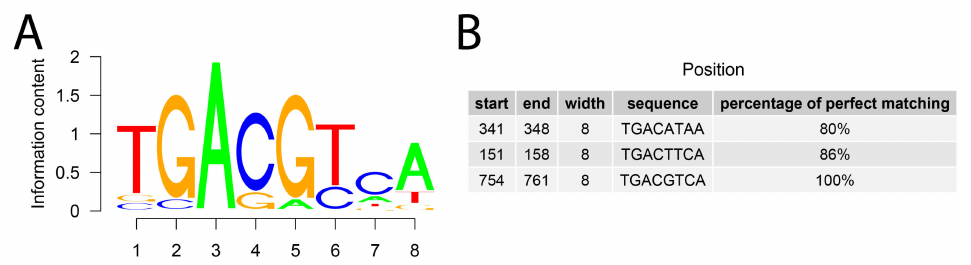
Figure 8. Analysis of the Giot1 gene promoter sequence for the presence of conservative CREB1 (cAMP responsive element binding protein 1) binding sequence. ( A ) Sequence logo based on CREB1 frequency matrix obtained from Jaspar—a database of transcription factor binding profiles (id: MA0018.2, http://jaspar.genereg.net/matrix/MA0018.2/ as at 03 August 2018); ( B ) table of potential binding sites of CREB1. The binding position within 1000 nucleotides of the promoter was indicated by start and end values. Width, promoter of sequence matched to frequency matrix and percentage of perfect matching were also